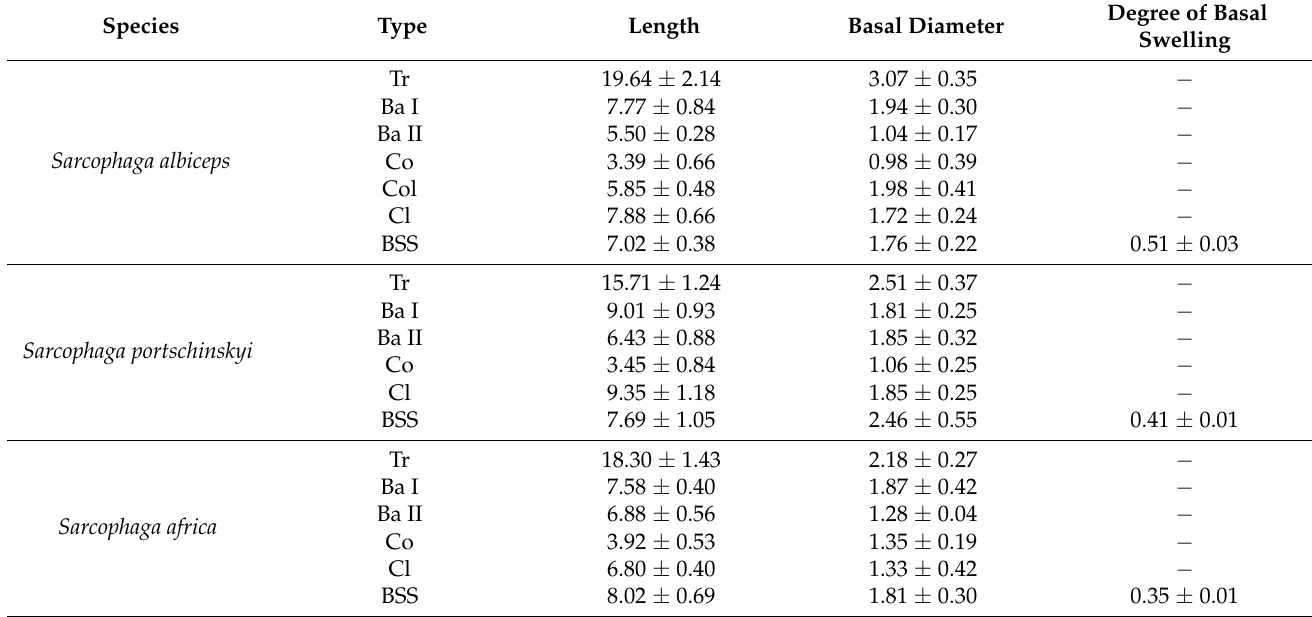
Table 2. Length, basal diameter, and degree of basal swelling (maximum diameter of the ‘neck’ of the bottle/maximum diameter of the bottle half) of the sensilla on the antennal postpedicel of nine male sarcophagid species ( µ m ± SD, n = 10). Abbreviations: Ba I (basiconic sensilla I); Ba